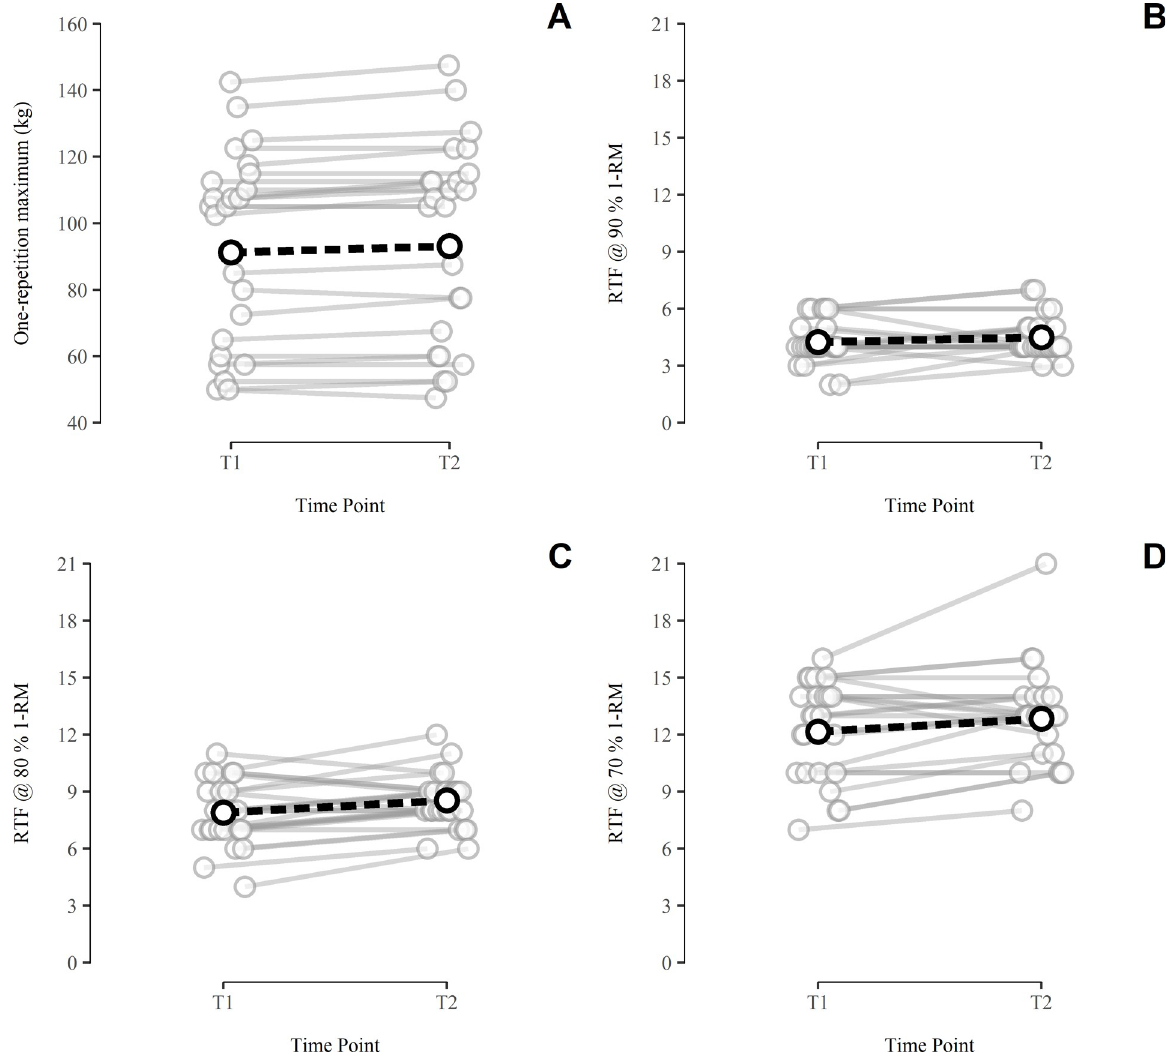
Fig 2. Variability of strength performance in the bench press. A, one-repetition maximum (1-RM); B, repetitions performed to momentary failure (RTF) at 90% 1-RM; C, RTF at 80% 1-RM; D, RTF at 70% 1-RM; grey circles, data points (jittered illustration); black circles, group means; solid grey lines, individual performance changes; dashed black lines, systematic performance changes ( Δ t